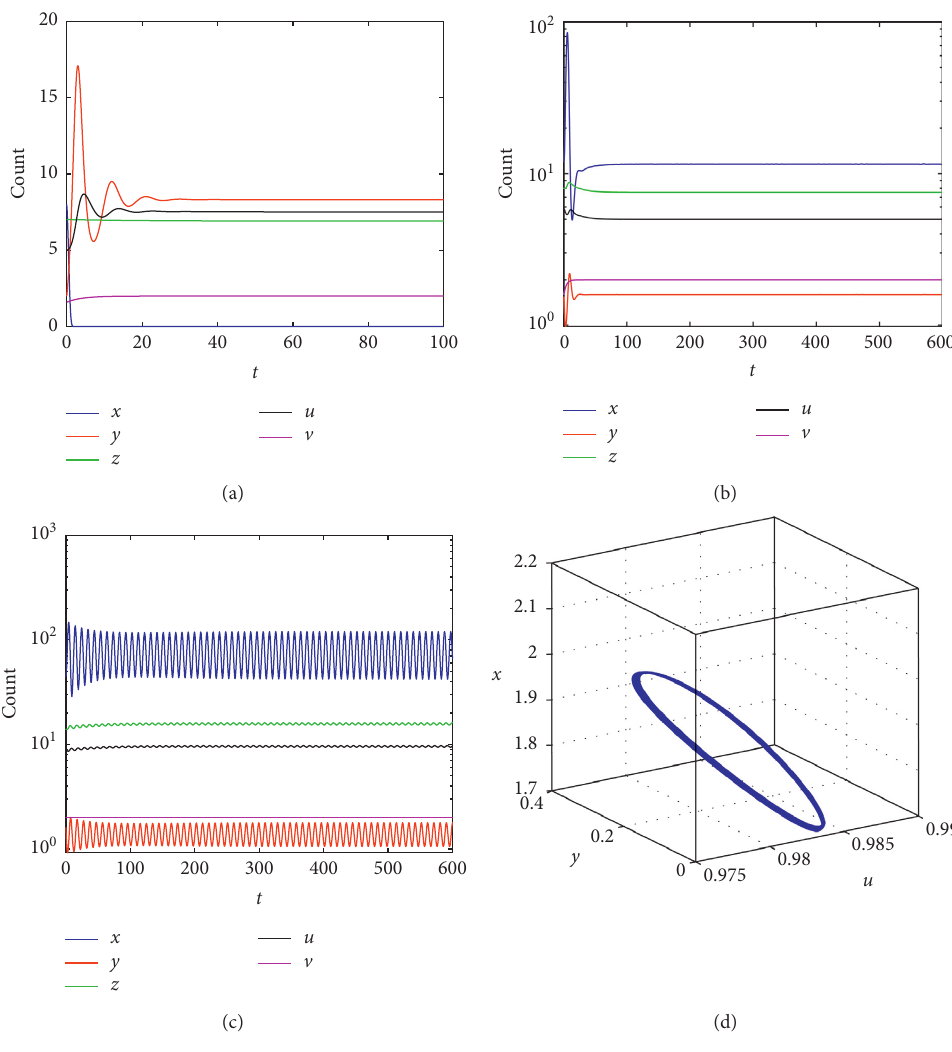
� σ � 0 . 5 , θ � 0 . 4, N ( 0 , 8 . 3 , 6 . 909 , 7 . 505 , 2 ) is LAS. (b) When σ 1 3 0 � 0 . 4 , σ � 0 . 5 , θ � 0 . 78, N ∗ ( 77 . 887 , 1 . 381 , 15 . 936 , 9 . 698 , 2 ) is unstable. (d) When 1 3